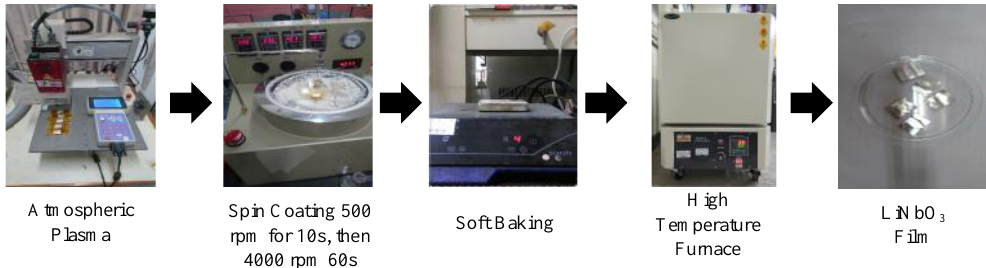
Figure 2. The photographs of fabrication of LiNbO 3 thin film.